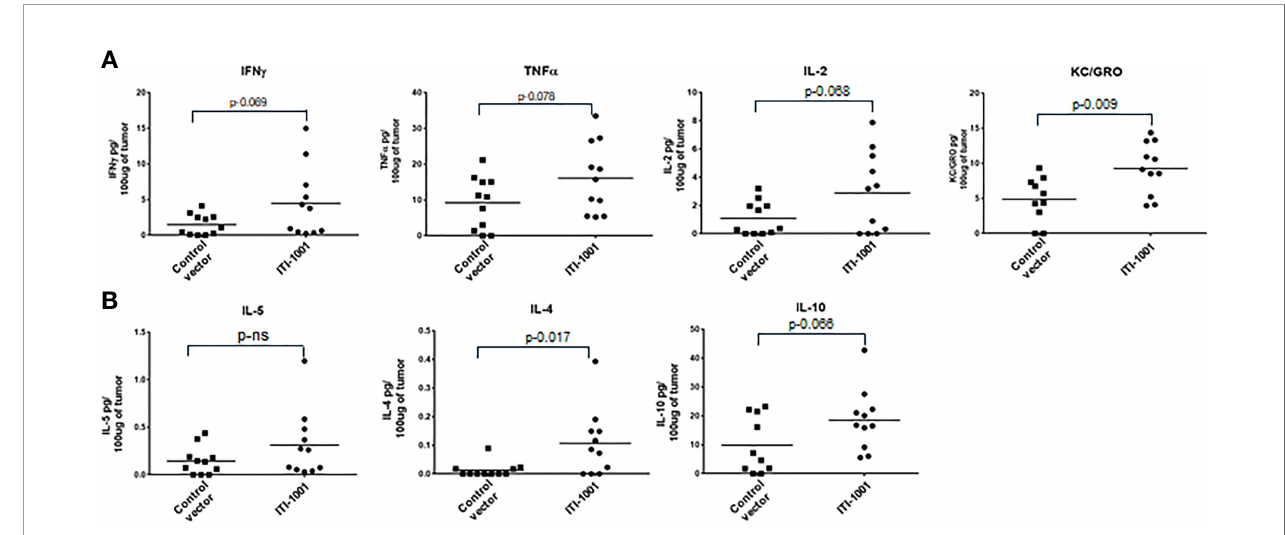
FIGURE 4 | Evaluating TME cytokine levels. (A) Cytokine levels denoted as pg/100 m g of tumor lysate for Interferon g , tumor necrosis factor a , IL-2, and Keratinocyte Chemoattractant/human Growth-Regulated Oncogene. (B) Cytokine levels for IL-5, IL-4, and IL-10 denoted as pg/100 m g of tumor lysate. p values from Student ’ s t- test are denoted to signify the statistical differences between the control and treated